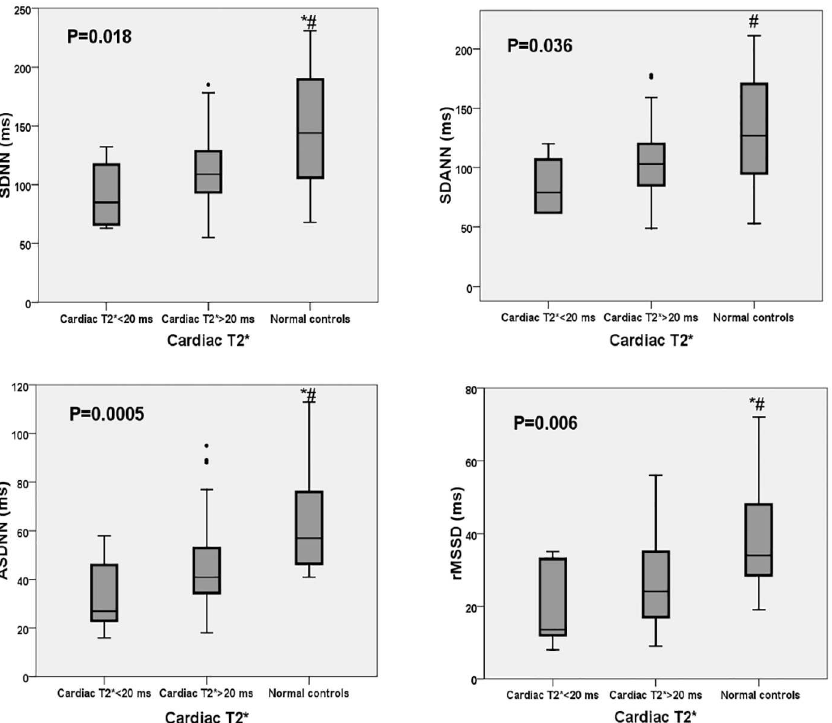
Fig 4. Graphing display comparing the time domains of HRV (SDNN, SDANN, ASDNN and rMSSD) according to cardiac T2 * . SDNN, the standard deviationof all normalsinus R-R intervals in the entire 24-hourrecording; SDANN, the standarddeviationof all averagenormalsinus R-R intervals for all 5-minute segments in the 24-hourrecordings; ASDNN, the averageof the standarddeviationof all R-R intervals for all 5-minutesegments in the 24-hourrecordings; rMSSD, the root mean squareof the mean of the squared differences of two consecutiveR-R intervals in the 24-hourrecordings. * —p < 0.05vs. cardiacT2 * < 20ms; #— p < 0.05for cardiacT2 * > 20ms vs.